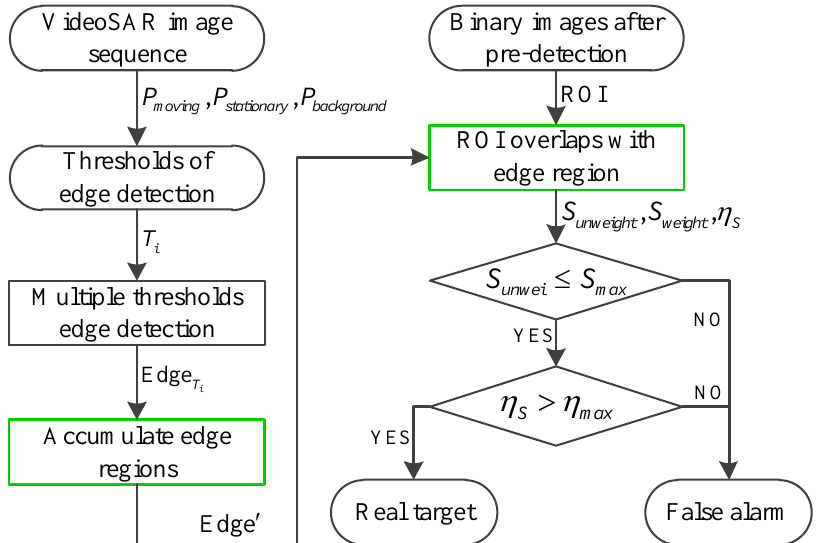
Figure 6. Flowchart of VideoSAR false alarm reduction method via gradient-weighted edge information. Green rectangles highlight the gradient-weighted procedures. Variables beside the arrows are transfered to the next operating